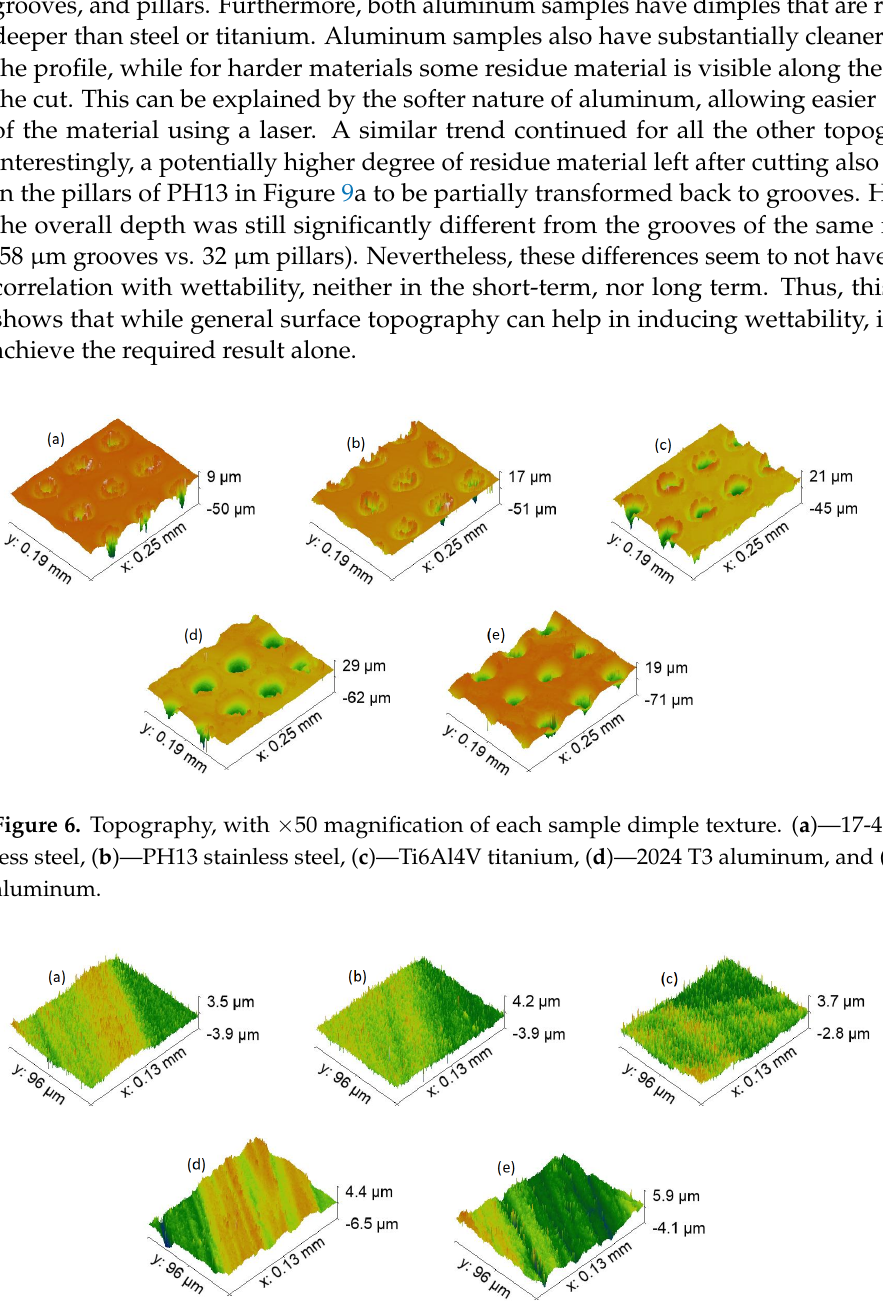
Figure 7. Topography, with × 100 magnification of each sample LIPSS texture. ( a )—17-4PH stain- less steel, ( b )—PH13 stainless steel, ( c )—Ti6Al4V titanium, ( d )—2024 T3 aluminum, and ( e )— 7050